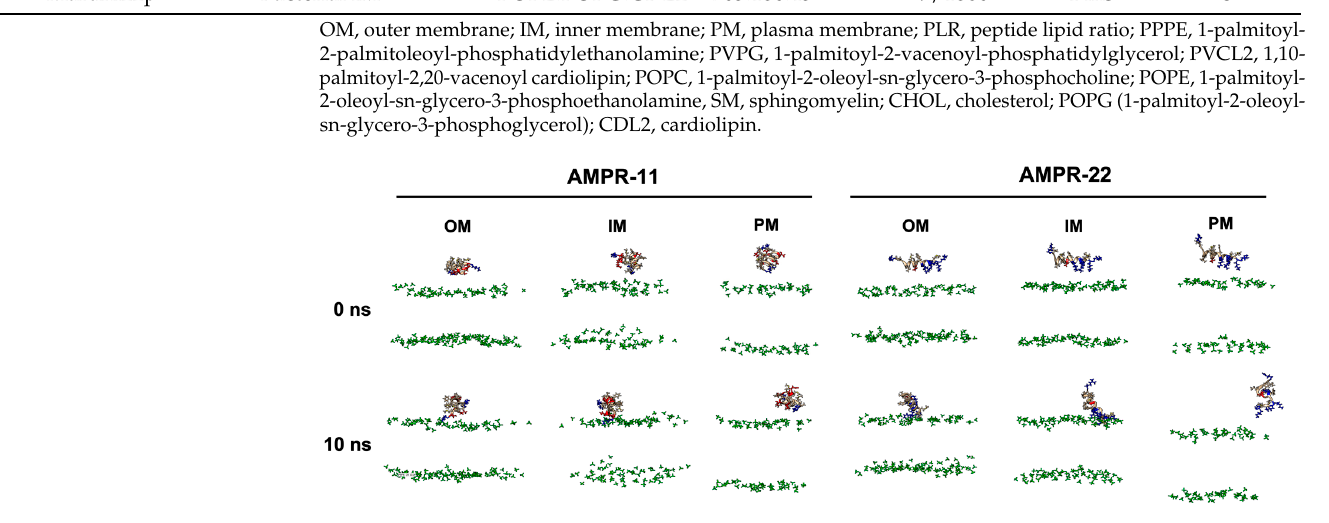
Figure 2. AMPR-11/22 interactions with Gram-negative bacterial outer membrane (OM), inner membrane (IM), or eukaryotic plasma membrane (PM). Each iteration having the average value of the hydrogen bonds formed between AMPR-11/22 and the membrane was selected: 25th (OM), 43rd (IM), and 43rd (PM) simulations from 100 iterations were selected for AMPR-11, and 1st (OM), 42nd (IM), and 48th (PM) simulations from 100 iterations were selected for AMPR-22. The phosphate group of the lipids is colored green. Hydrophobic (nonpolar), hydrophilic (polar), and cationic residues of AMPR-11/22 are shown in copper, red, and blue, respectively.